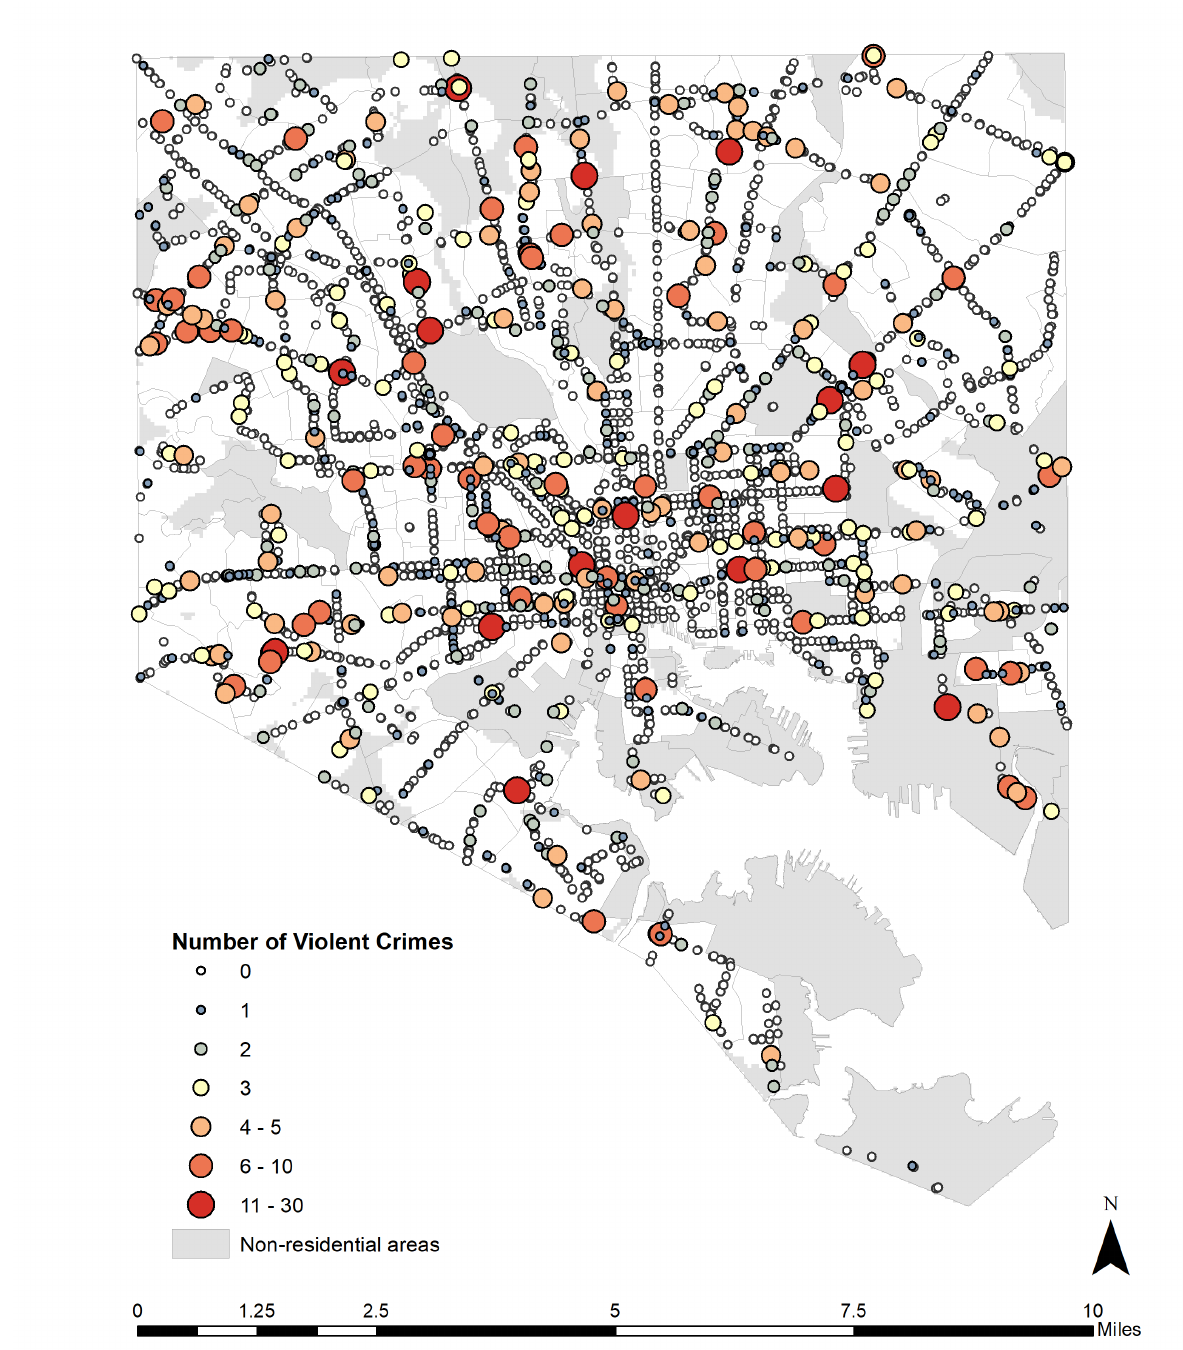
Figure 2: Transit stops by number of violent crimes (2014–2015 academic year). Source : Authors’ calculation is based on data from the Baltimore Police Department, the Maryland Transit Administration, and the Baltimore City Public